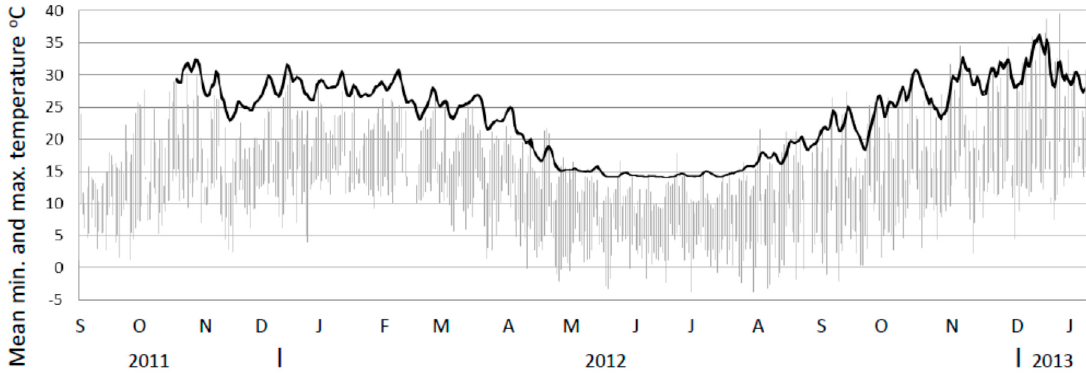
Figure 5. Internal temperature profile of untreated mounds (mean minimum to maximum range) for untreated mounds ( n = 9 up till January 2012 and n = 10 thereafter) from November 2011 to January 2013 (black line). Note. Mound minimum and maximum temperatures are so close they appear as a single line. Ambient temperature ranges from the closest weather station shown in grey. Note.